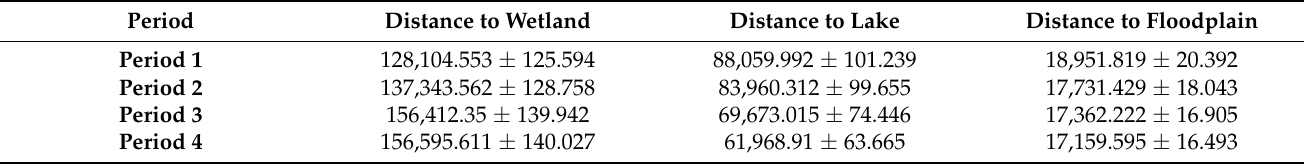
Table A2. The average of the three variables in the four